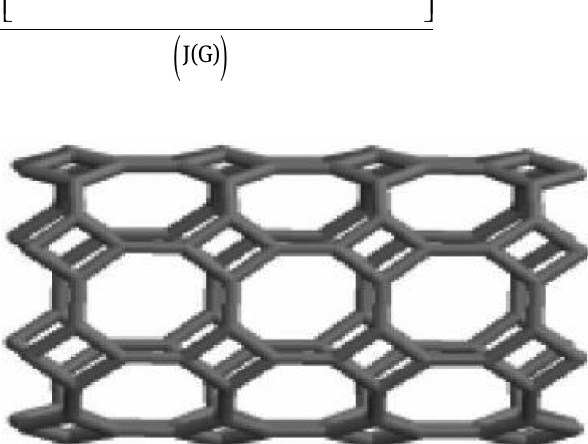
C (R)[m, n] nanotube. 4 8